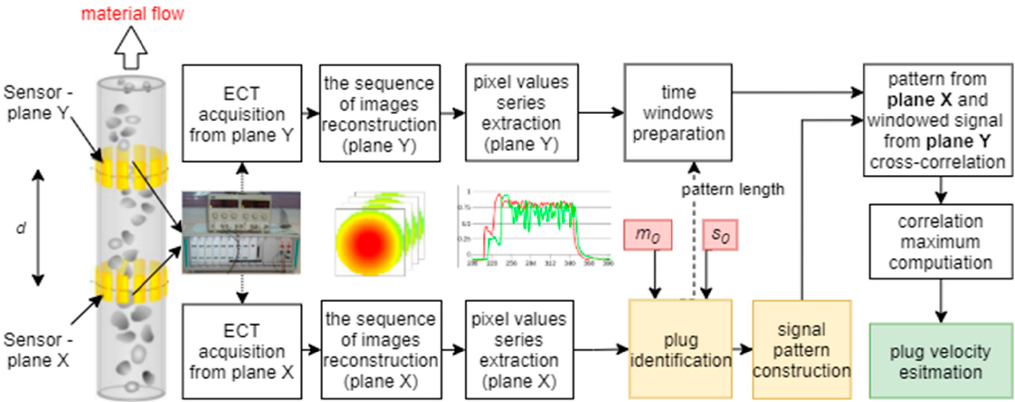
Figure 1. Diagram of flow velocity measurement realized by a two-plane-sensor electrical capacitance tomography (ECT) tomography, d is the distance between the two planes.